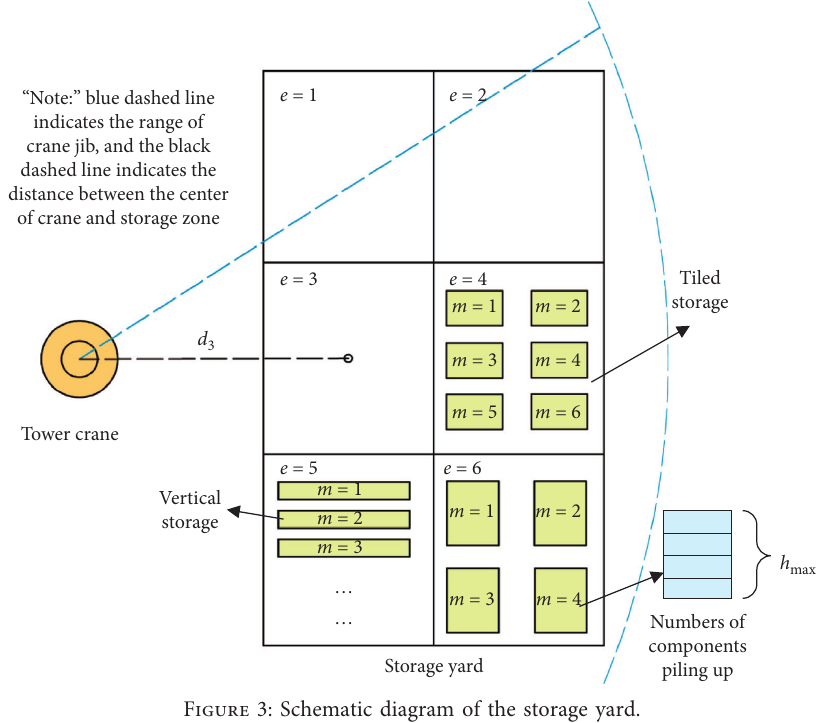
Figure 3: Schematic diagram of the storage